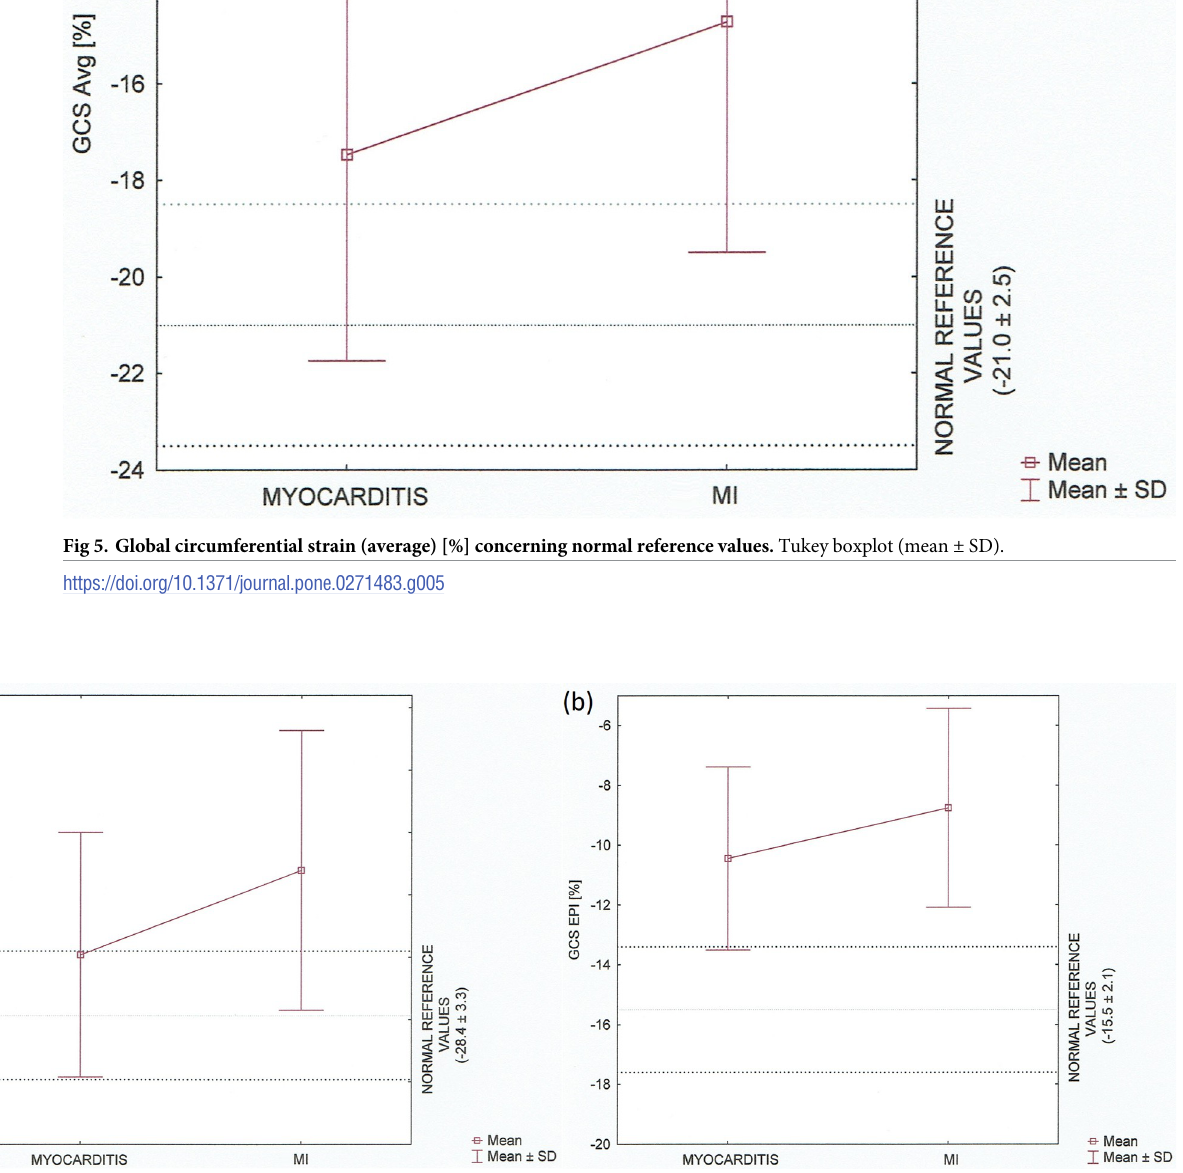
PLOS ONE | https://doi.org/10.1371/journal.pone.0271483 August 8, 2022 10 /